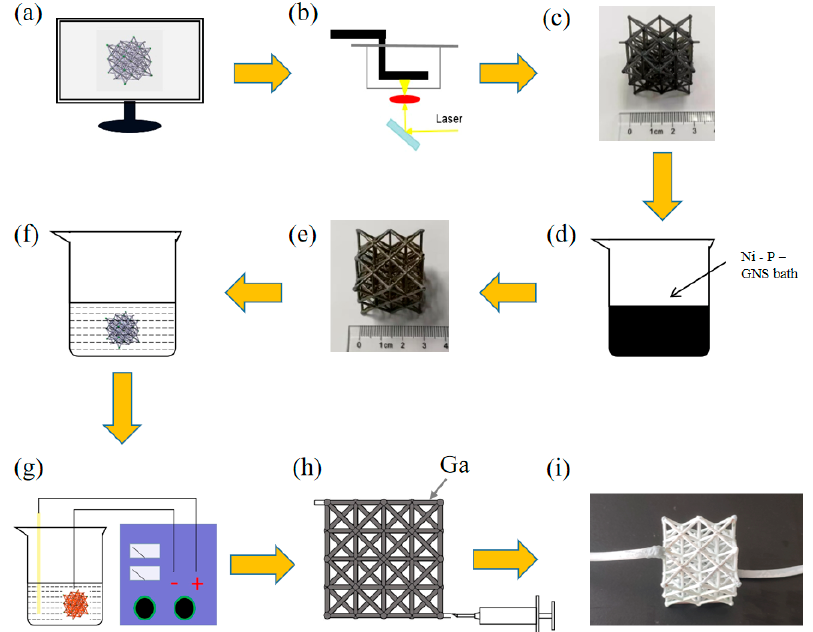
Figure 6. Fabrication of the microlattice cooling system. ( a ) Computer micro-architectural design. ( b ) 3D printing. ( c ) Polymer template. ( d ) Chemical plating. ( e ) Ni-P-GNS thin film template. ( f ) Chemical etching of template removal. ( g ) Electro-coppering. ( h ) Liquid Ga injection. ( i ) Microlat- tice cooling system.